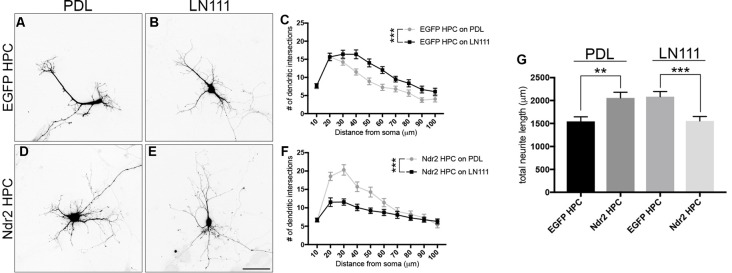
Overexpression of Ndr2 kinase impairs α1β1-dependent dendritic growth of hippocampal primary neurons. Primary hippocampal neurons transfected with EGFP plasmid and plated on (A) PDL and (B) Laminin-111 (LN111). (C) Sholl analysis of their dendrites reveals that LN111 substrate increases the dendrite branching significantly compared to PDL coating (two-way ANOVA between substrates: F(1,57)= 12.59, p = 0.0008, n = 30 each). (D–F) On the other hand, when Ndr2 overexpressing neurons are plated on the same substrates, Sholl analysis shows higher dendritic branching of Ndr2 hippocampal primary culture (HPC) on PDL rather than LN111 substrate (two-way ANOVA between substrates: F(1,57)= 15.46, p = 0.0002, n = 29 for PDL and 30 for LN111). (G) Total dendritic length of Ndr2 HPC is increased compared to EGFP PC12 cells on PDL and but reduced on LN111 substrate (one-way ANOVA: F(3,115) = 7.72, p < 0.0001). Values are mean + SEM; **p < 0.01; ***p < 0.001.